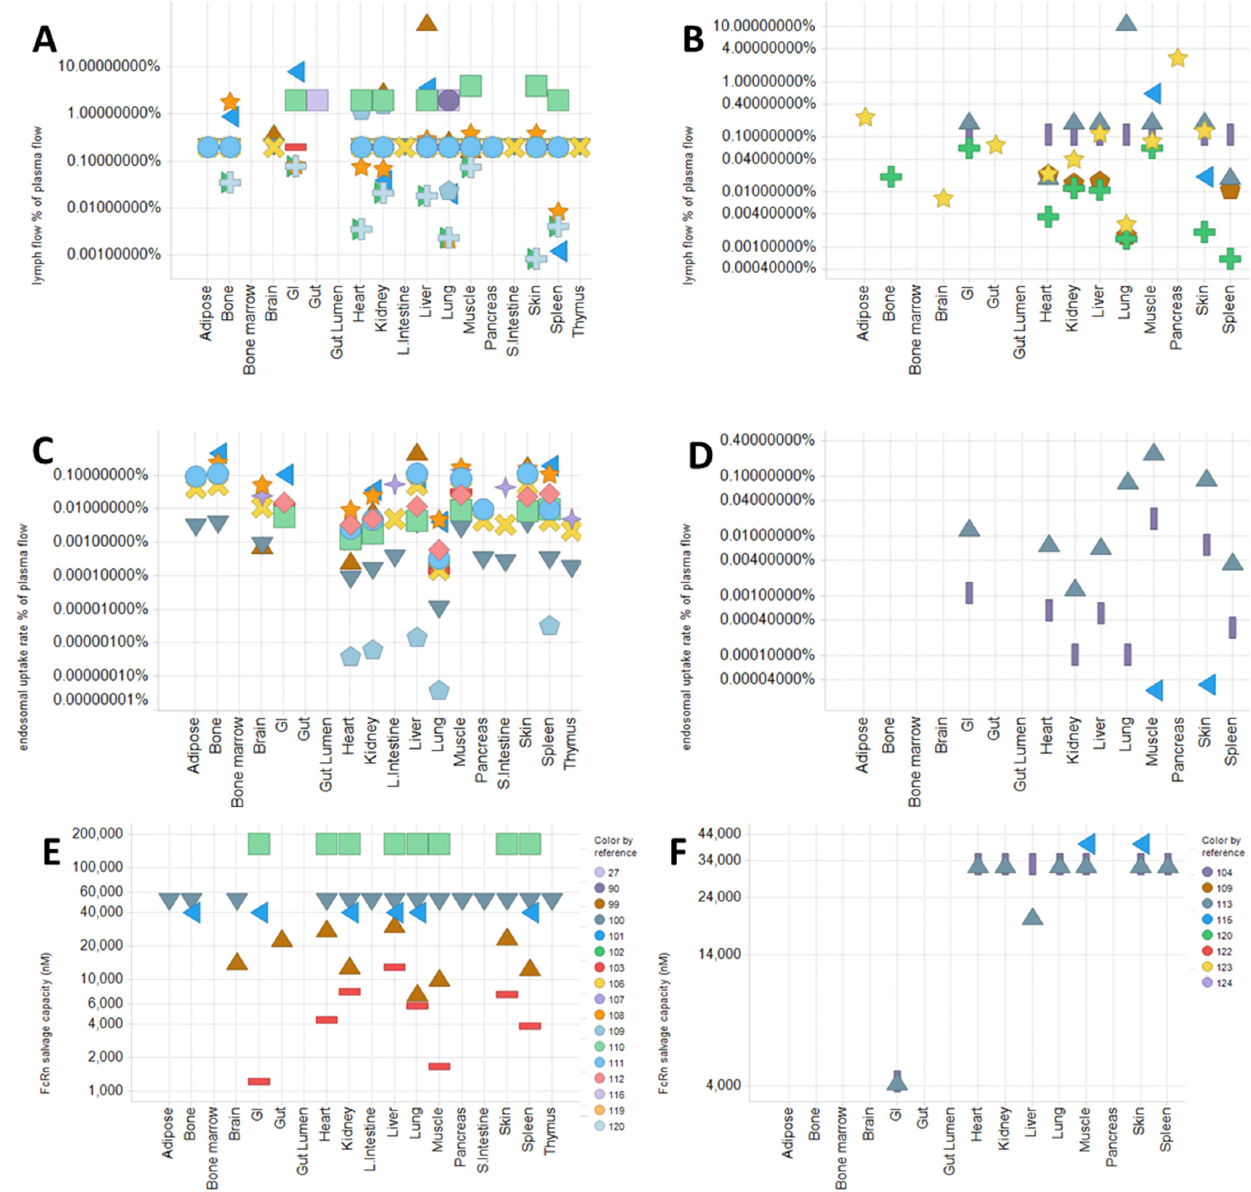
Figure 3. Representative physiological parameter values used in PBPK models in the different literature Literature values of percentage of lymph flow per plasma flow ( A , B ), percentage of endosomal uptake clearance per plasma flow ( C , D ), and FcRn concentration ( E , F ) of mouse ( A , C , E ) or human ( B , D , F ) in each organ used for PBPK model. Each symbol represents a different literature. The total endosomal volume in catenary model was calculated as five-fold volume of the endosomal sub-compartment [110,111,120].